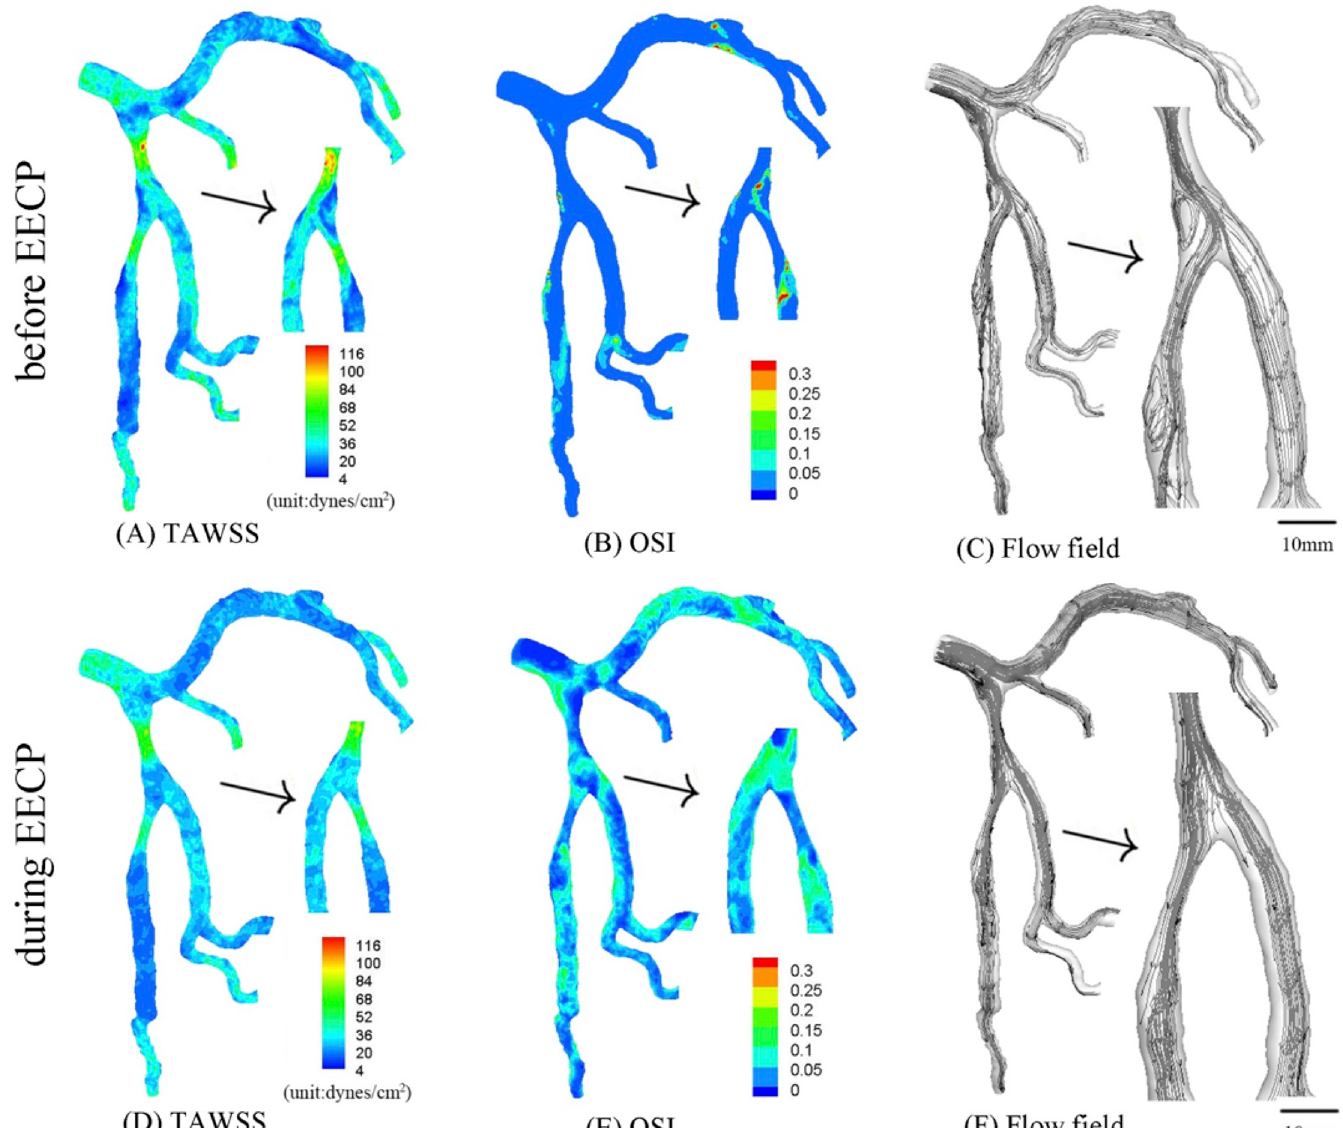
Fig 5. In correspondence with Fig 1A, TAWSS (A), OSI (B) and flow field (C) in the epicardial tree that has an idealized 75% area stenosis at the parent vessel (stenotic length of 7.3 mm) and an idealized 75% area stenosis at the large daughter vessel (stenotic length of 7.9 mm) in the first bifurcation of LAD arterial tree before EECP; TAWSS (D), OSI (E) and flow field (F) in the same tree during EECP. The small figures for TAWSS and OSI show the posterior view. The small figures for flow field show the zoomed